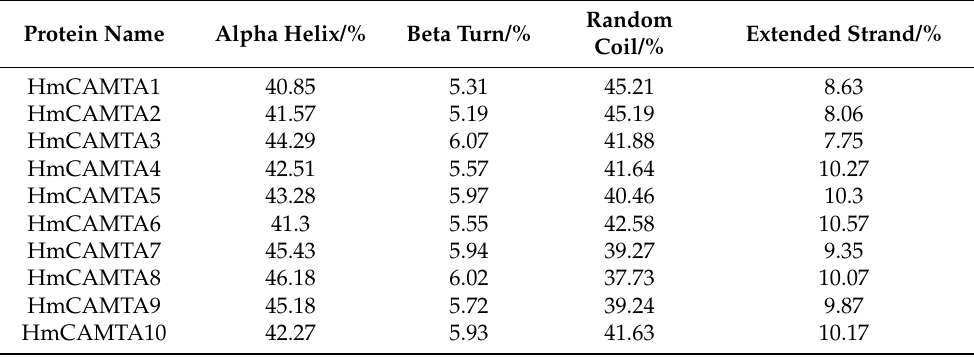
Table 2. Secondary structure prediction of